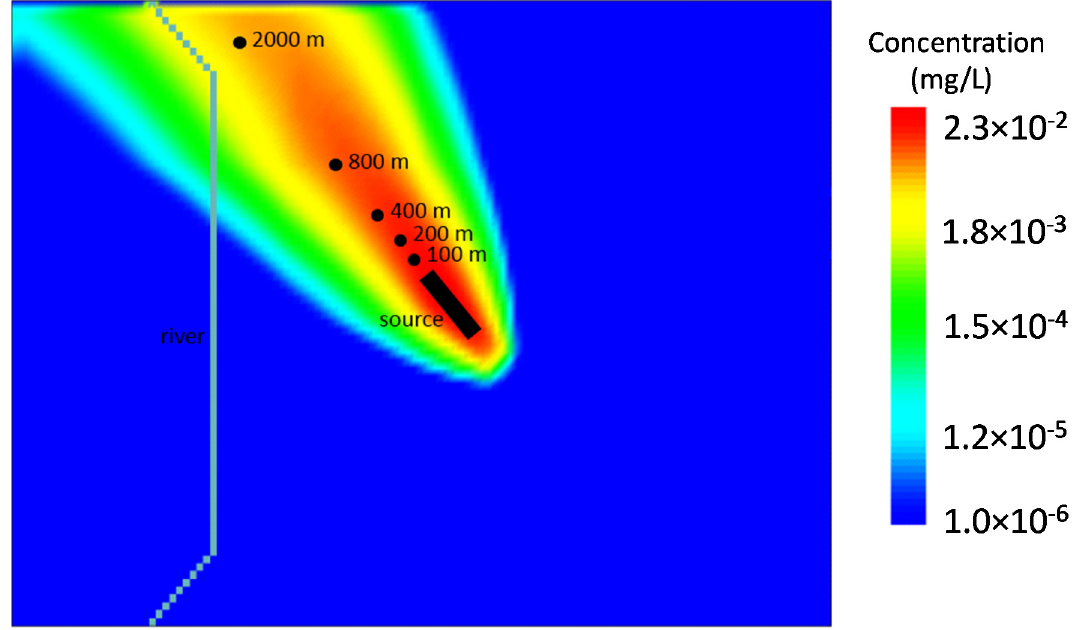
Figure 5. Example solute plume after 1500 years following a long-term release from a leaking storage pond. A unit input concentration at the soil–groundwater interface is assumed (i.e., C 0 = 1 mg/L). Solute concentrations are collected at 100, 200, 400, 800, and 2000 m.